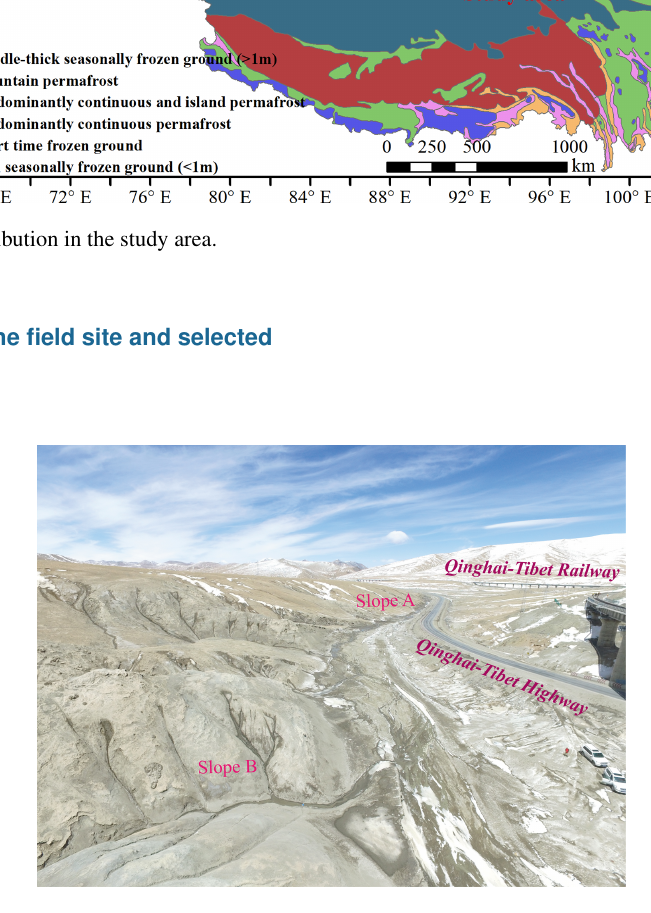
Earth Syst. Sci. Data, 13, 4035–4052,